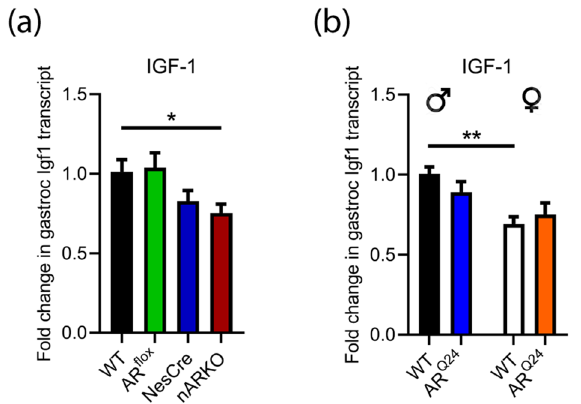
Figure 5. AR expression levels do not drive an alteration in skeletal muscle IGF-1 transcript. (a) IGF-1 transcript levels in gastrocnemius muscle of AR flox x NesCre male mice at 2 months age. Data represents mean ± SEM, n = 5 mice per group. *P < 0.05 by one-way ANOVA with Dunnett’s multiple comparison test comparing all genotypes to WT. (b) IGF-1 transcript levels in gastrocnemius muscle of male and female AR Q24 mice compared to WT at 3 months age. Data represents mean ± SEM, n = 6 mice per group. **P < 0.01 by two- way ANOVA with Sidak’s multiple comparisons test comparing sex